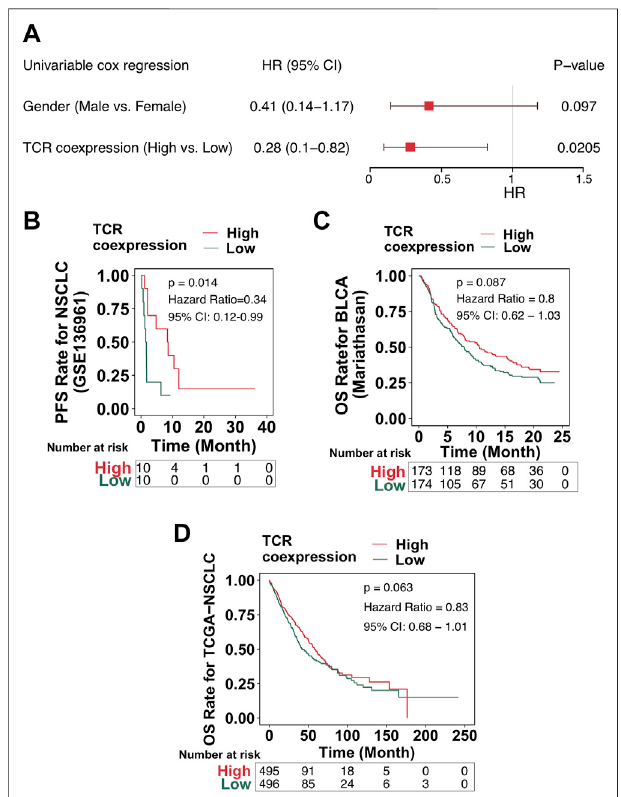
FIGURE 2 | High TCR coexpression signature was associated with improved prognosis of patients receiving immunotherapy. (A) The results of the univariate regression analyses displayed as a forest map (GSE136961). The main part of the forest map is used to show the HR and 95% con fi dence intervals. Factors associated with improved prognosis are log10(HR) < 1, and those associated with poor prognosis are log10(HR) > 1. (B) KM survival curves of PFS for NSCLC patients from the ICI cohort (GSE136961). (C) KM survival curves of OS for patients in the ICI-BLCA cohort (Mariathasan et al.). (D) KM survival curves of OS for patients in the TCGA-NSCLC